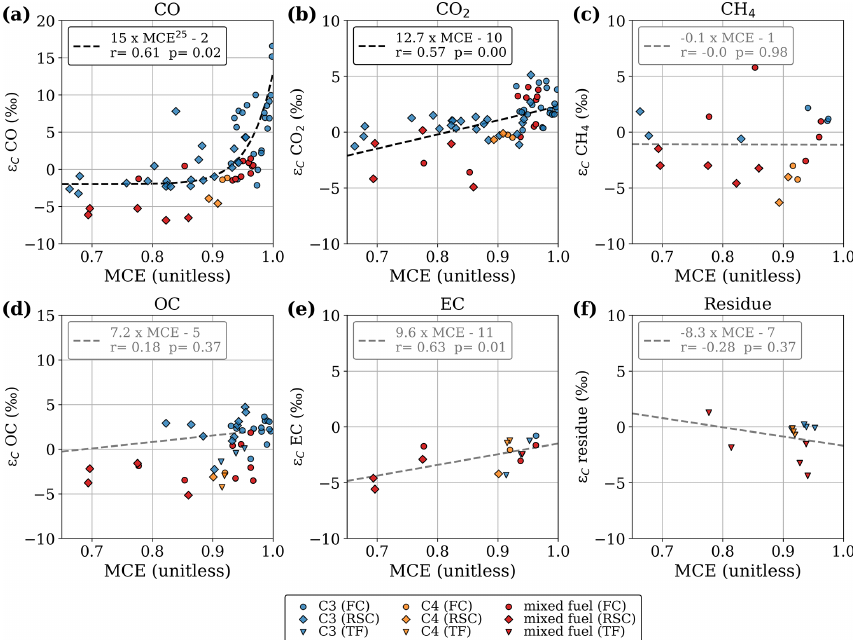
Figure 3. Stable carbon isotope fractionation compared to the precursor fuel, plotted against modified combustion efficiency. Results are presented separately for flaming combustion (FC), residual smouldering combustion (RSC), and total fire (TF) samples. Non-significant linear fit lines ( p > 0.1) are presented in grey.